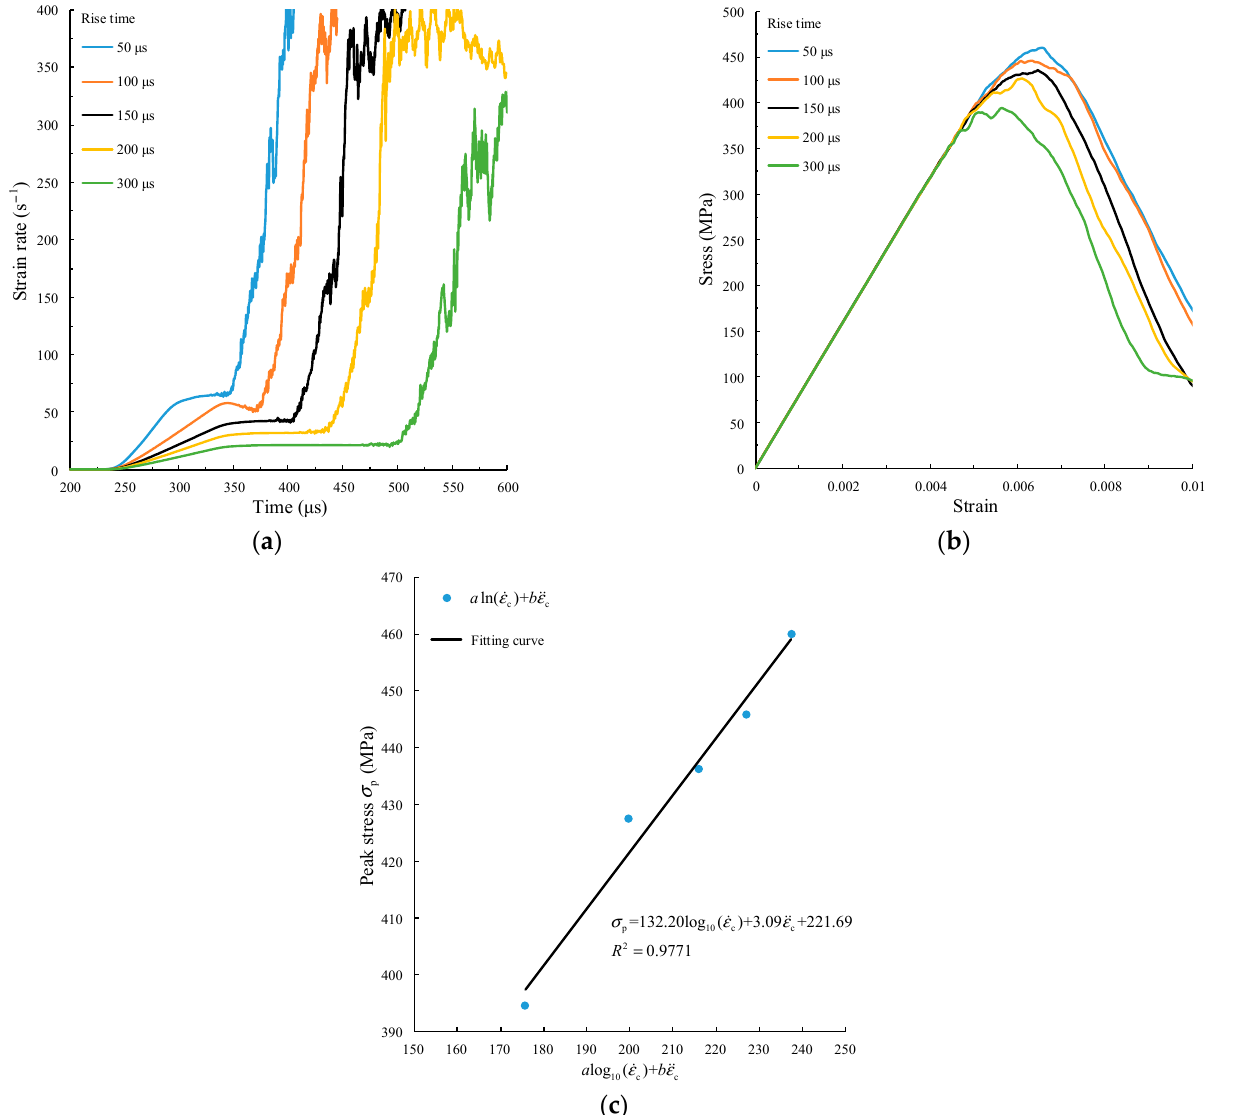
Figure 15. Calculation results under different rise times. ( a ) Time history curves of strain rate; ( b ) stress–strain curve; ( c ) fitting relation between peak stress and strain rate and strain rate gradient. Figure 15a,b show that when the amplitude and upper bottom time of the force pulse waveform remain unchanged but the rise time is too large, the strain rate gradient, strain rate, and peak strength will decrease with the increase of rise time. Figure 15c shows the fitting curve obtained by using the prediction model in Equation (8), and the fitting formula is as follows: The fitting degree R 2 reaches 0.9771, which indicates that the prediction model can effectively describe the dynamic peak strength of the specimen under the impact of a force pulse waveform with different rise times. Lee’s test results [47] are used to verify the reliability of the model. Three groups of data with the same sample size but different static compressive strengths are extracted. The sample size is 50 mm × 50 mm. The fitting result is shown in Figure 16, and the fitting formula is shown in Equation (11).